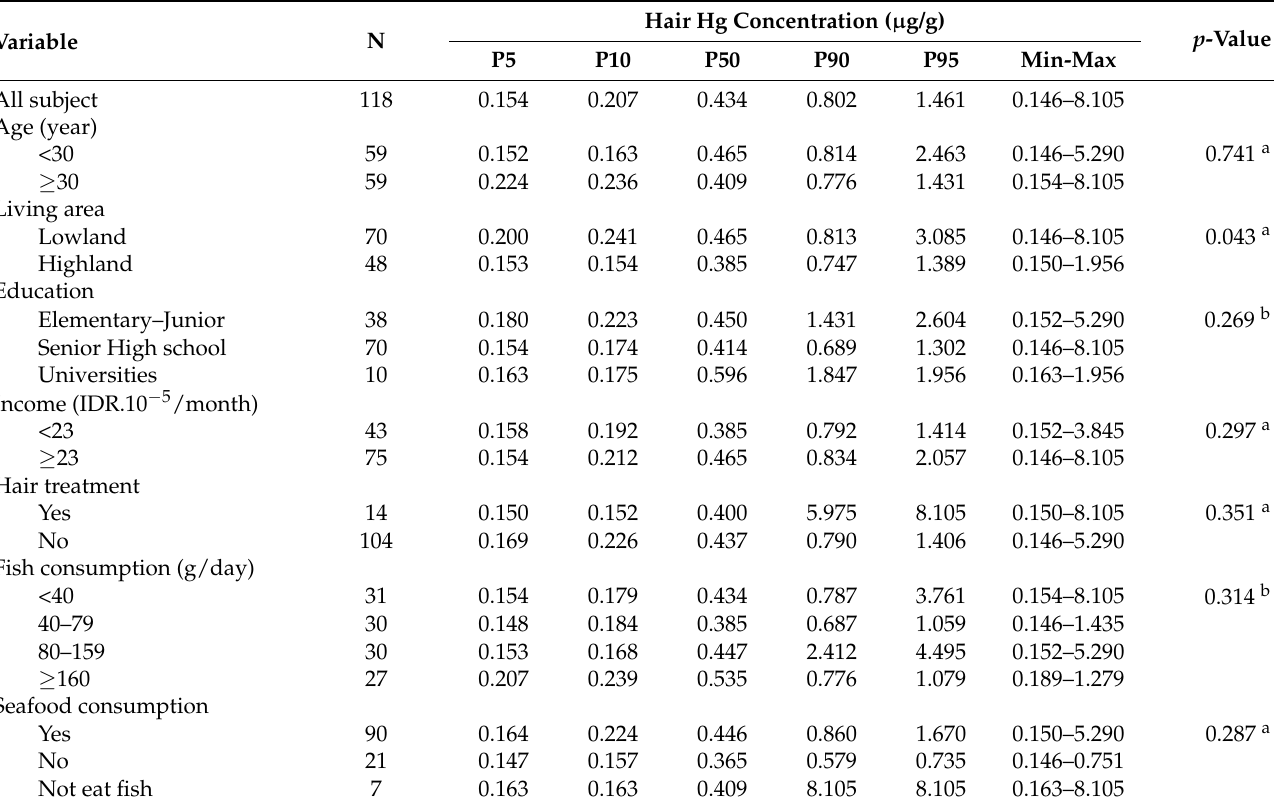
Table 3. Comparison of total hair Hg concentrations concerning several maternal